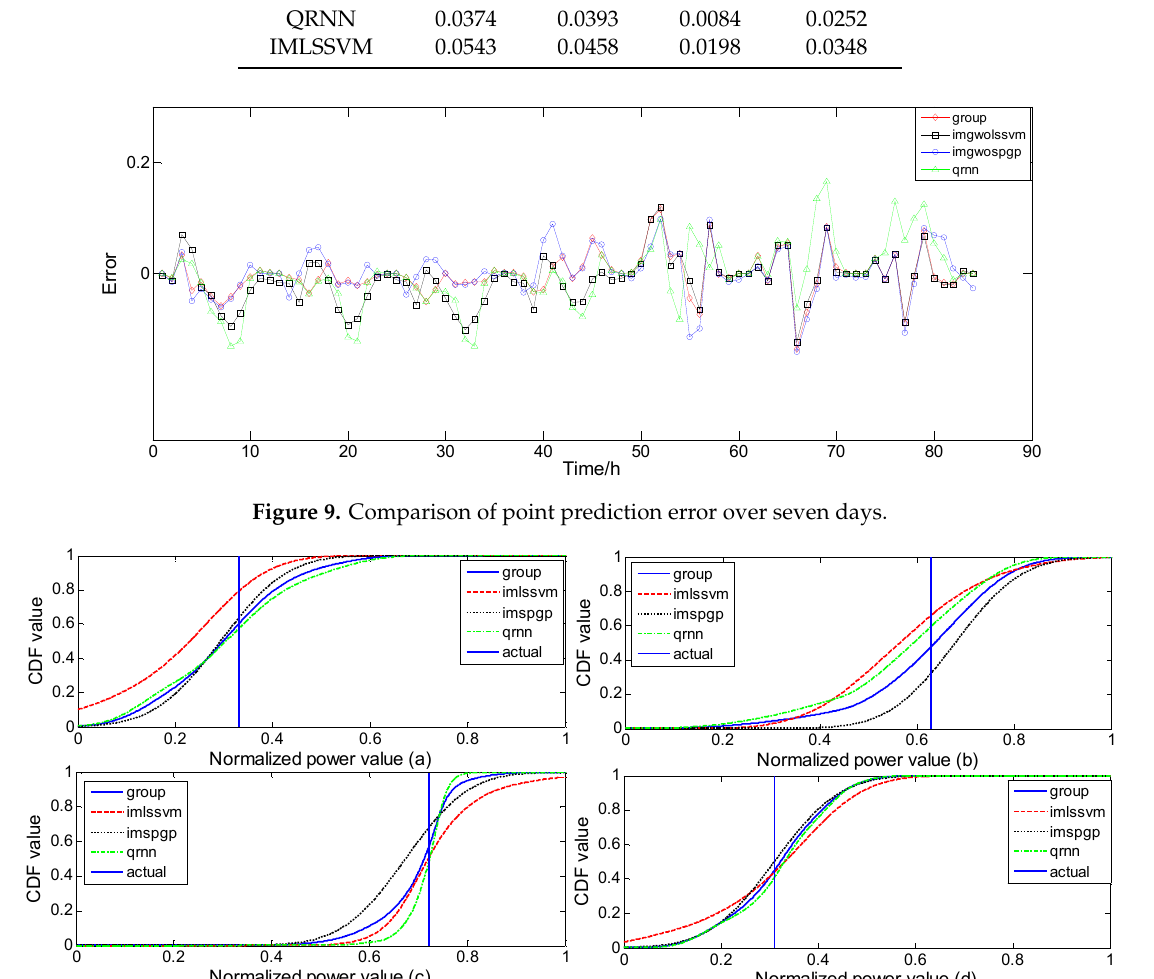
Figure 10. Multi-point cumulative distribution function in different intervals. Table 9. Evaluation indices of different models during four months.